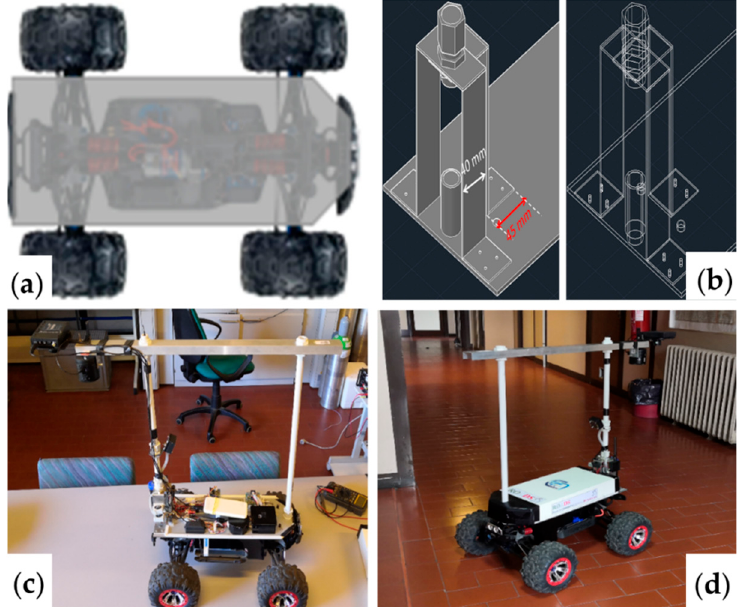
Figure 2. The figure shows the following: ( a ) UGV chassis based on Traxxas Summit model 56076, 1/10 scale, the top overview of the UGV, ( b ) the autocad project showing the base of the main tubular brackets support, ( c ) electrical and sensor adapting and image-based sensors ( d ) UGV with ROADS-project cover ready for field survey.